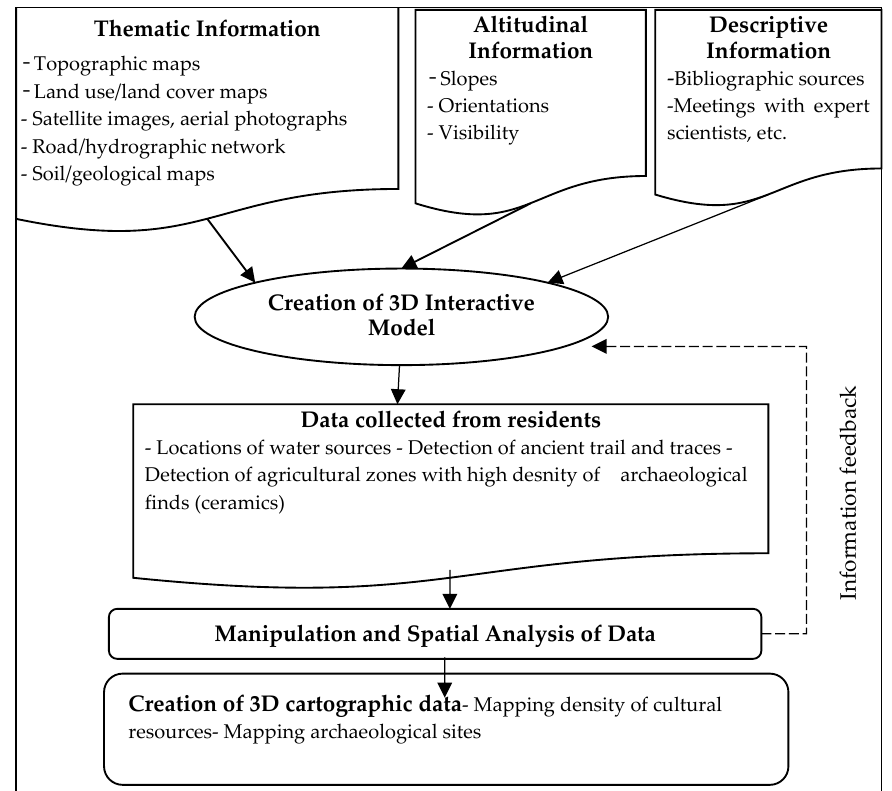
Figure 6. Flowchart of 3D GIS model and data analysis.